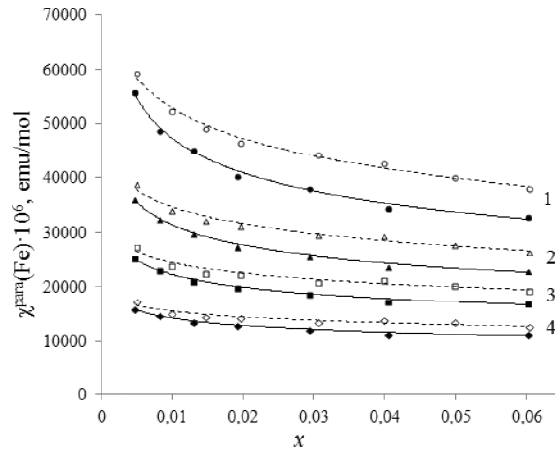
Fig. 3 . Isotherms of paramagnetic component of magnetic susceptibility of the iron-containing solid solutions Bi BaNb Fe O (dotted lines) and 2 2-2 x 2x 9-  Bi Nb Fe O (solid lines) at 90K (1), 140K (2), 5 3-3 x 3 x 15-  200K (3), 260K